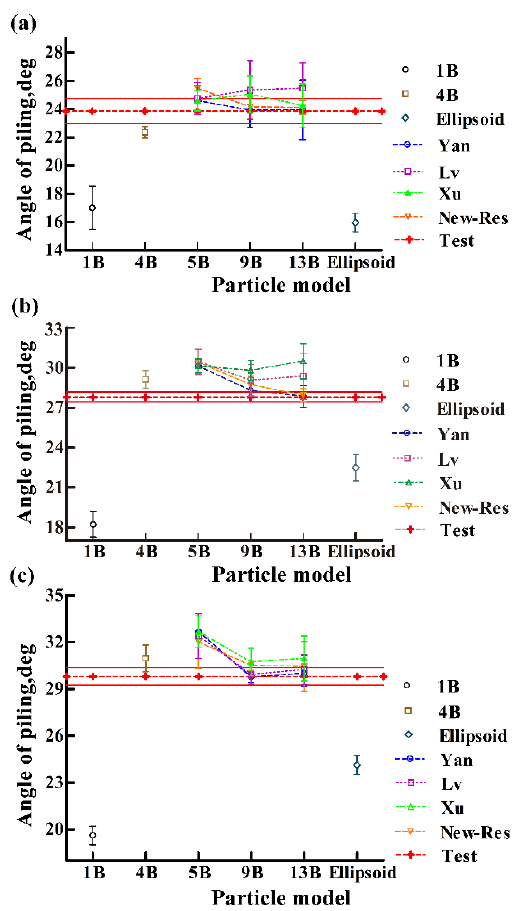
Figure 22. Comparisons between the test results and the simulation results of different models in